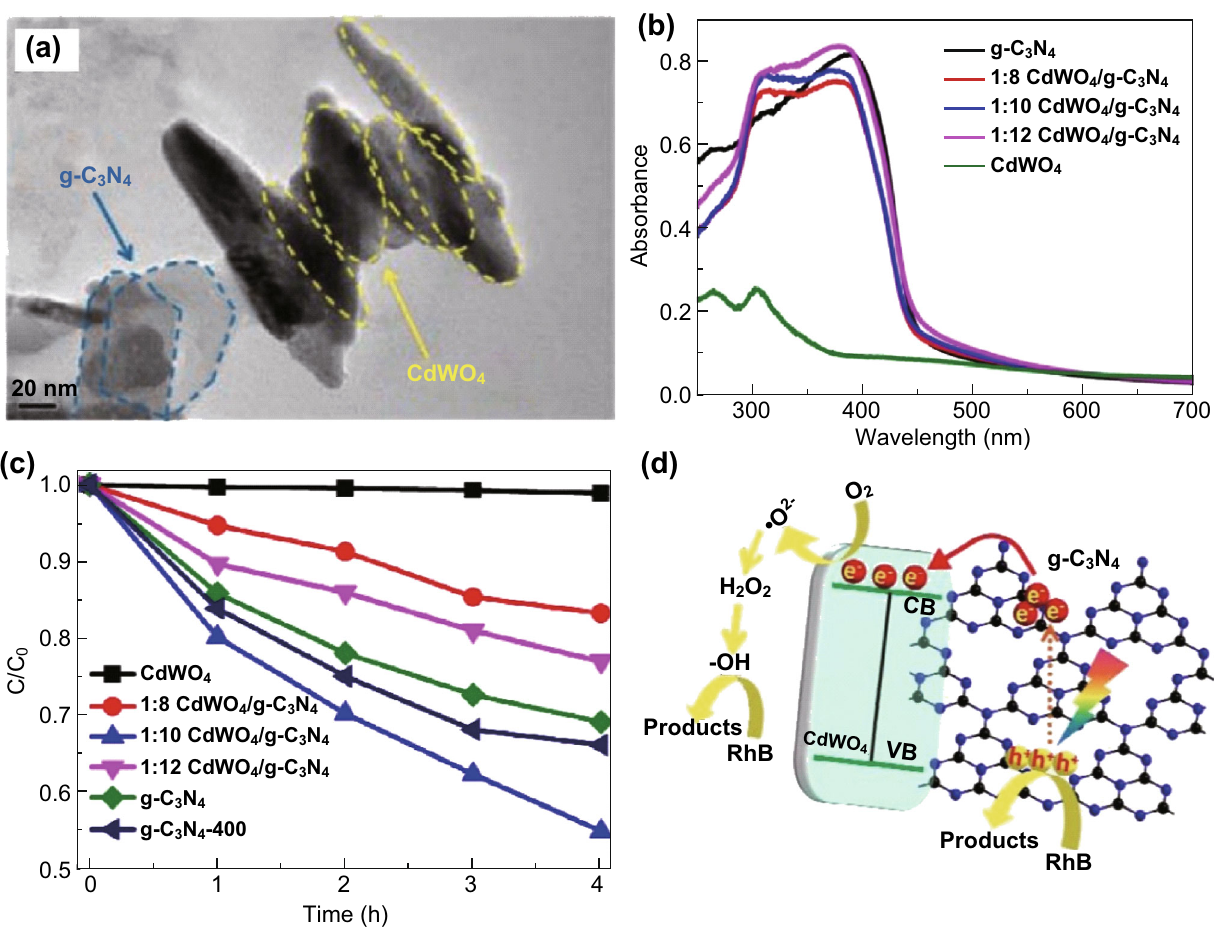
Fig. 16 a TEM image, b UV–vis diffused reflectance spectra, and c photocatalytic degradation curves of CdWO 4 /C 3 N 4 . d Mechanism of photocatalytic reaction on the CdWO 4 /C 3 N 4 . Reproduced with permission from Ref. [197]. Copyright 2015